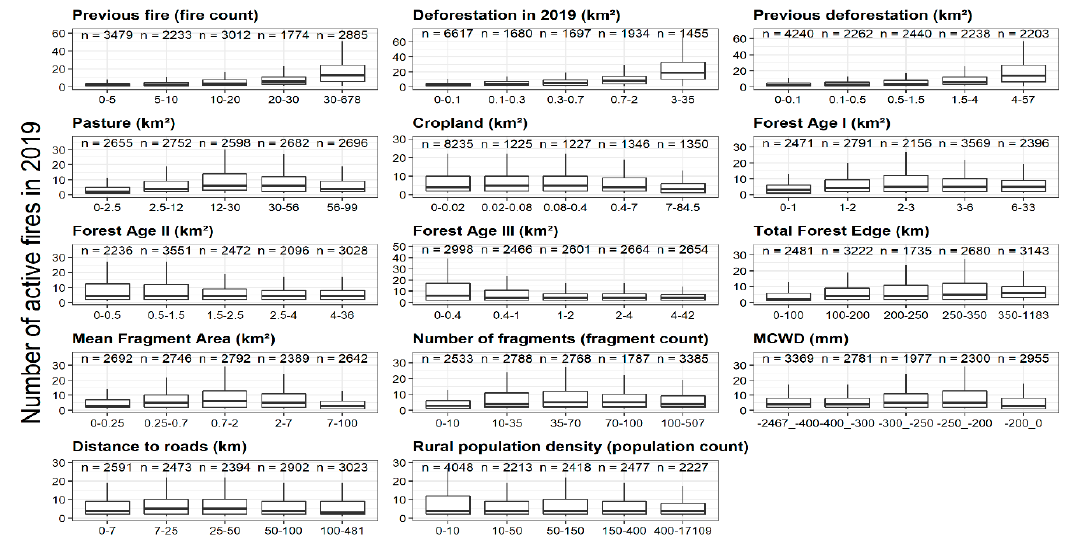
Figure 6. Boxplots showing the distribution of 2019 active fires in grid cells according to magnitude intervals in each driver distribution. Each grid cell has an area of 10 × 10 km. The “n” on top of each magnitude interval refers to the respective number of grid cells. Outliers were removed from the analysis for visualization purposes.